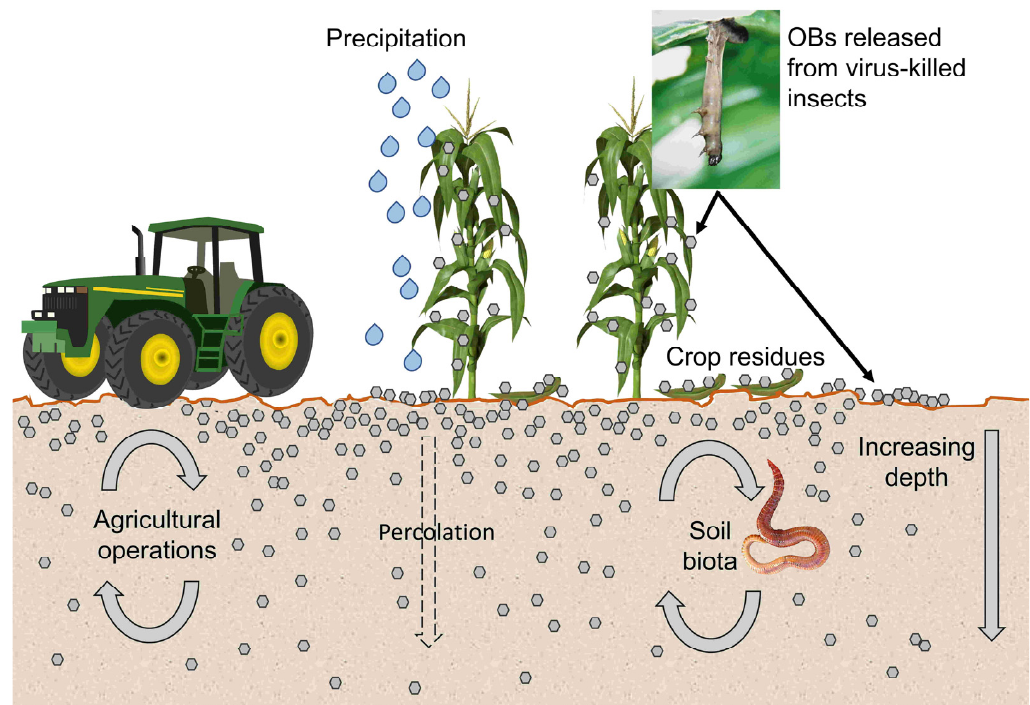
Figure 2. Mechanisms by which virus occlusion bodies (OBs) are transported from diseased insects and contaminated foodplants to the soil and within the soil reservoir. OBs (indicated by small grey hexagons) released from host insects enter the soil from virus-killed cadavers, or they contaminate plant foliage and are washed into the soil by precipitation. Contaminated plant residues also decay on the soil surface and provide an additional source of OBs. The OBs that adhere to soil particles are washed downward by percolation of rainwater (dashed arrow) or are moved through soil layers by agricultural operations such as tillage or by the soil biota (solid curved arrows). The images of plants, earthworm and tractor are available for reproduction under a creative commons license (CC BY; Microsoft O ffi ce). Table 2. Estimates of natural OB populations in untreated soil.